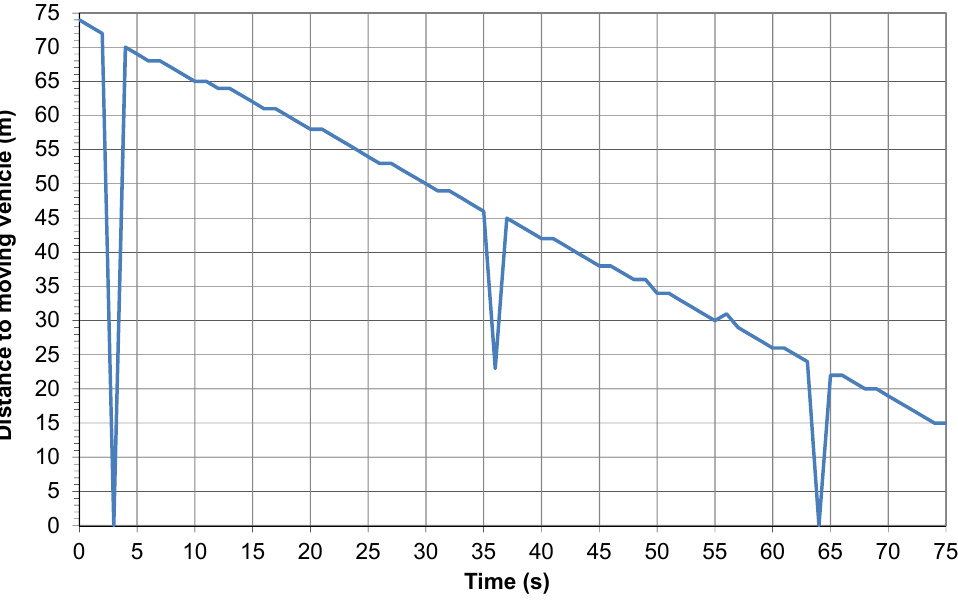
Figure 9. Anomalies in the distance measurement.